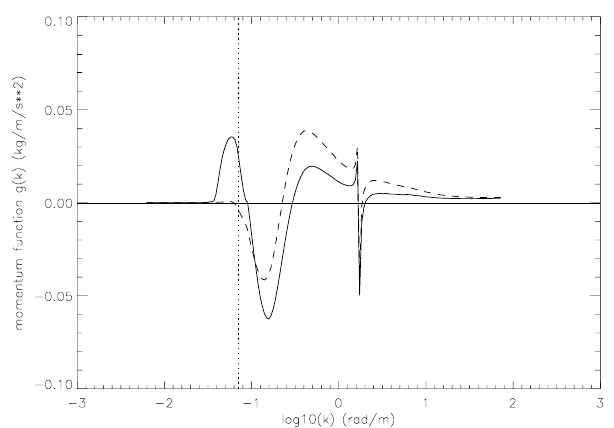
Fig. 4. Momentum function g(k) (Eq. 33a) as a function of log 10 (k) . Wind speed is taken as 10ms − 1 . The sea wave spectral model is the same as in Fig. 2, with high wavenumber spectrum from Elfouhaily Figure 4. Momentum function g(k) (equation (33a)) as a function of log 10 (k). Wind speed is et al. (1997). The dotted vertical line indicates the position of the taken as 10m/s. The sea wave spectral model is the same as in Figure 2, with high 1000 spectral peak k p . The wave breaking term β br is from Komen et wavenumber spectrum from Elfouhaily et al. (1997). The dotted vertical line indicates the al. (1984), and the wind input term β w is from WAMDI (1988). position of the spectral peak k p . The wave breaking term β br is from Komen et al. (1984), and the wind input term β w is from WAMDI (1988). Solid line : results from the model of this Solid line results from the model of this paper. Dashed line results paper. Dashed line : results from the classical approach taking γ = γ 1 . The discontinuity near from the classical approach taking γ = γ 1 . The discontinuity near log 10 k=0.2 rad/m is an artefact produced by the change of directional spreading function of log 10 k = 0 . 2radm − 1 is an artefact produced by the change of di- the model sea wave spectrum taken at k=25k p . rectional spreading function of the model sea wave spectrum taken at k = 25 k p